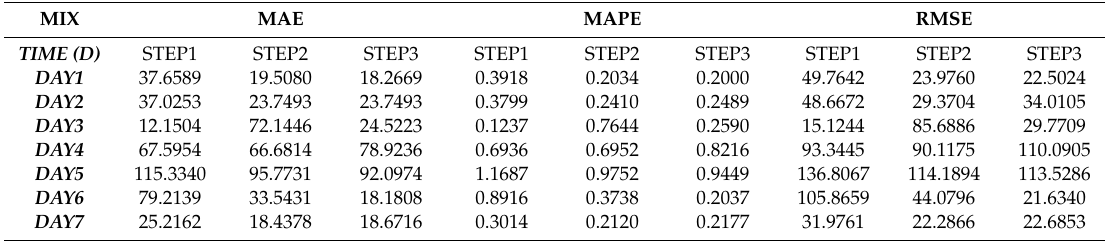
Table 4. One-step, 2-step, and 3-step of the typical results of the combined model for a week in NSW.